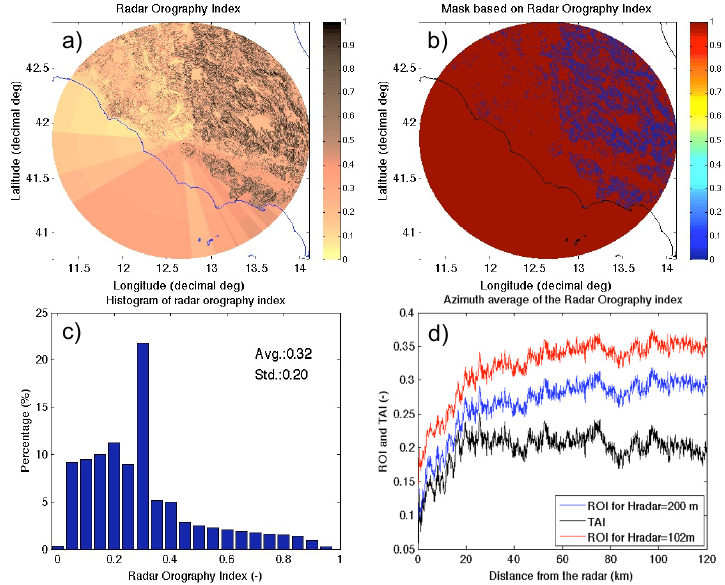
Figure 4. ( a ) Map of the Radar Orography Index (ROI) in the P55C radar domain when lowest beams are considered; ( b ) radar mask where position having ROI > 0.6 are equal to 0 and 1 otherwise; ( c ) distribution of the ROI values in (a); ( d ) average ROI as a function of the distance from the radar for radar altitudes at 200 m and 102 m and the curve of the Terrain Altitude Index TAI (Equation (9) using G TA instead of G RO ).